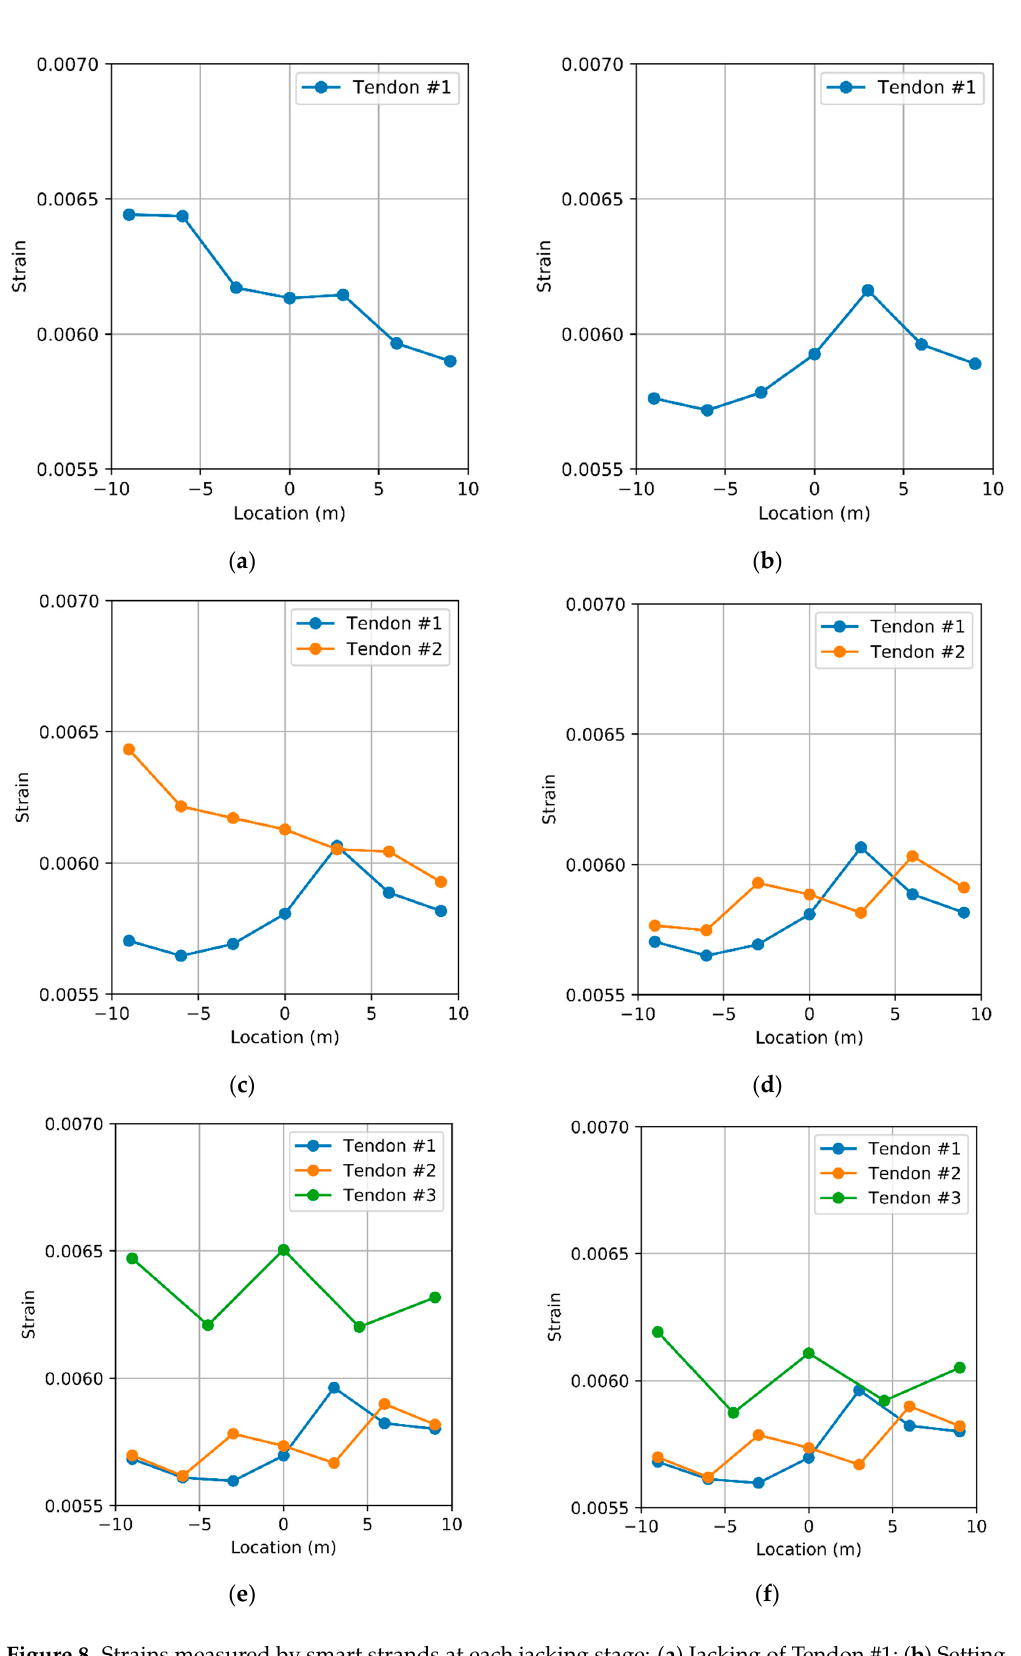
Figure 8. Strains measured by smart strands at each jacking stage: ( a ) Jacking of Tendon #1; ( b ) Setting of Tendon #1; ( c ) Jacking of Tendon #2; ( d ) Setting of Tendon #2; ( e ) Jacking of Tendon #3; ( f ) Setting of Tendon #3.